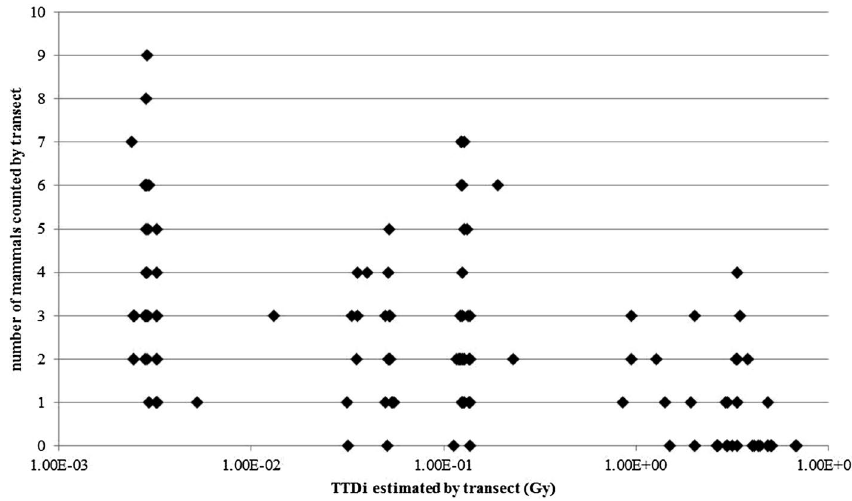
Figure 5. Variation in the number of mammals counted by transect as a function of TTD i .